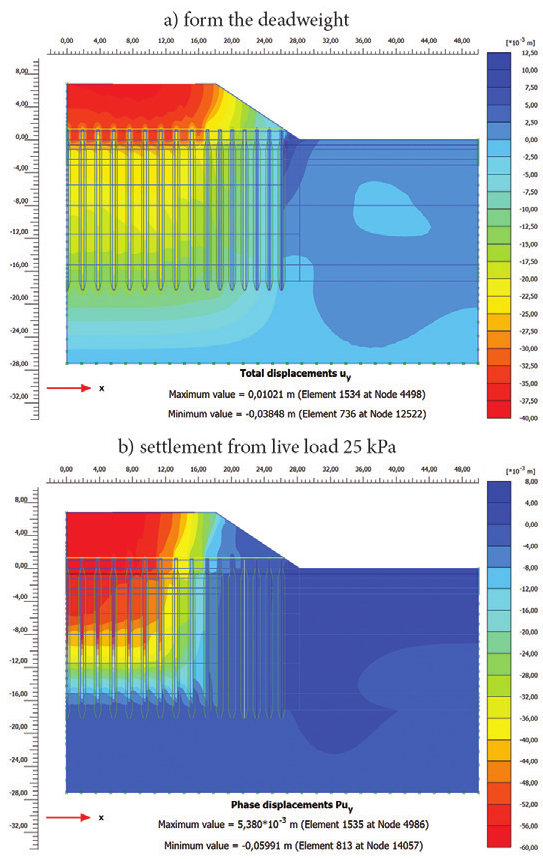
Fig. 9. Simulations of embankment